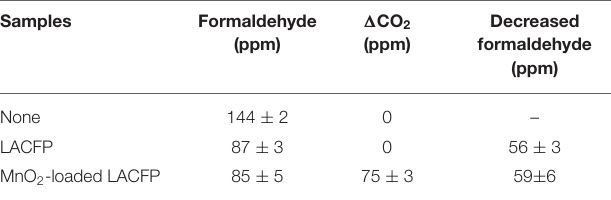
TABLE 6 | The values of formaldehyde and 1 CO 2 over three different samples when the reaction was finished. Samples Formaldehyde